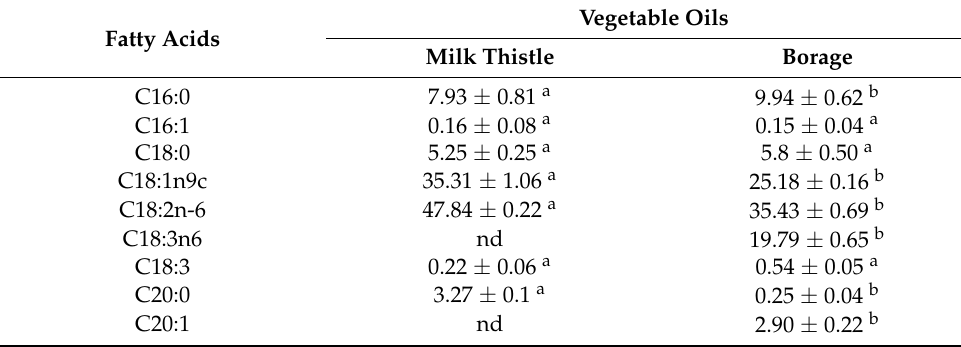
Table 2. Content of fatty acids in the analysed oil samples (%).